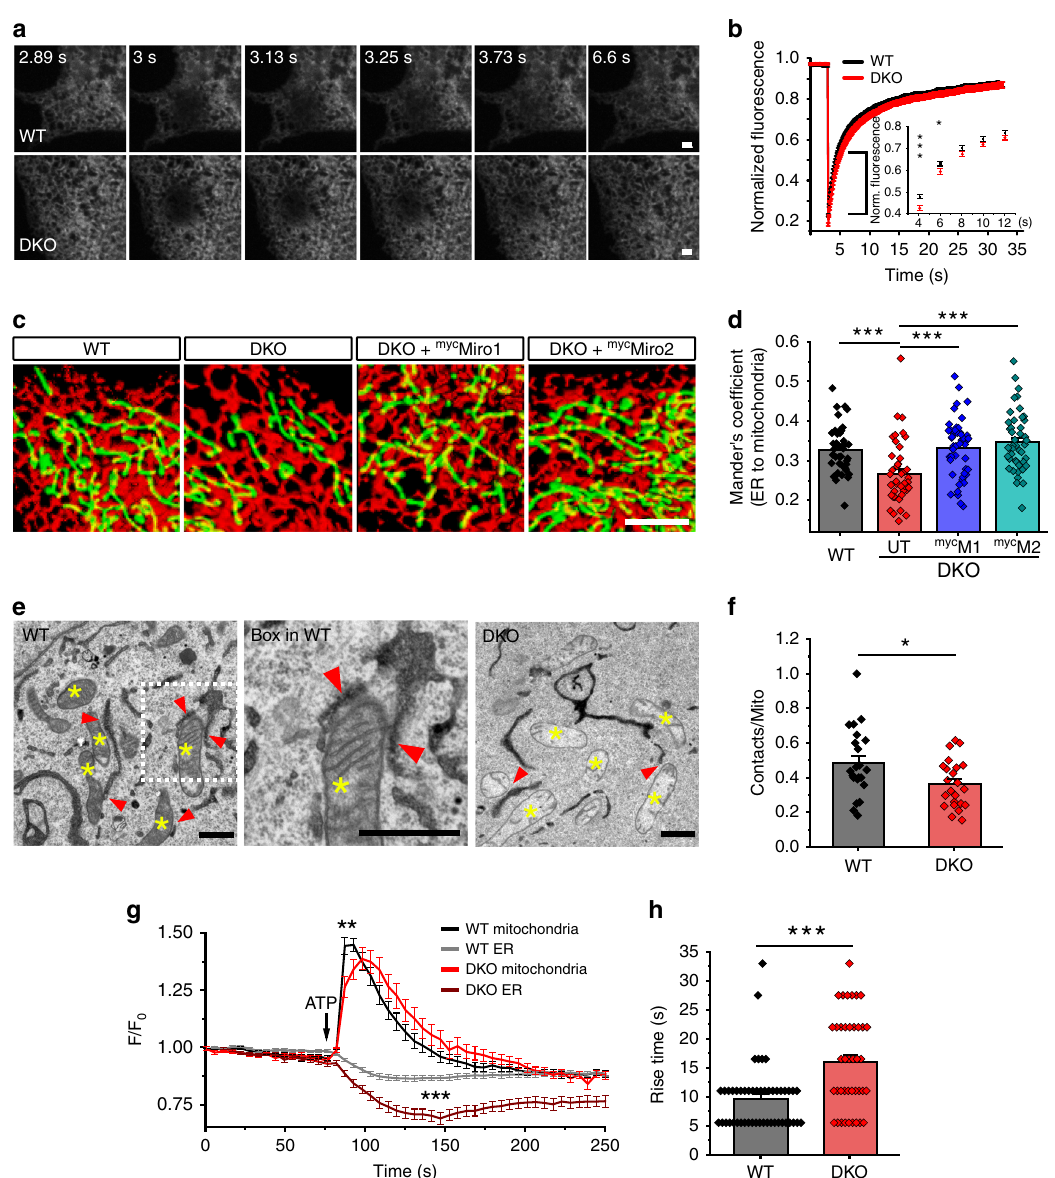
Fig. 2 Miro control ER/mitochondria communication by regulating the number of ERMCS. a FRAP analysis of ER dynamics measured in MEF cells transfected with DsRed ER (scale bar: 2 μ m). b Quanti fi cation of images shown in ( a ). Inset: expanded region of fi rst 12 s of the recovery after bleaching (fraction of recovery at 4 s: WT ~0.47 ± 0.01, DKO ~0.42 ± 0.01, p = 0.0010; and after 6 s: WT ~0.63 ± 0.01, DKO ~0.59 ± 0.01, p = 0.0311; Student ’ s t test with Welch ’ s correction; n = cells; in which 37 WT and 38 DKO cells were analyzed from three independent experiments). c Representative images of MEF cells expressing GFP Su9 and DsRed ER (scale bar: 10 μ m). d Quanti fi cation of Mander ’ s coef fi cient between the ER and mitochondria from ( c ) ( n = cells; in which 40 WT, 45 DKO, 47 DKO re-expressing Miro1, and 46 re-expressing Miro2 cells were used from three independent experiments; one-way ANOVA, Bonferroni post hoc). e Electron micrographs of the mitochondria and ER in WT and DKO cells expressing an HRP construct fused to an ER retention signal (KDEL). Yellow asterisks depict the mitochondria; red arrows point to the ER/mitochondria close contacts (< 35 nm). A magni fi ed view from the WT image depicts close contacts between the ER and mitochondria (scale bar: 200 nm). f Quanti fi cation of ERMCS in TEM images ( n = cell; in which 22 WT and 23 DKO cells were used, from two independent sample preparations; Student ’ s t test with Welch ’ s correction). g Agonist induced Ca 2 + release from the ER and subsequent mitochondrial Ca 2 + uptake. Arrow indicates addition of agonist ATP ( n = 49 WT and 41 DKO cells for the mitochondria and n = 47 WT and 39 DKO cells for ER were analyzed from fi ve independent experiments; Student ’ s t test with Welch ’ s correction). h Rise time (calculated from baseline to maximum amplitude after addition of ATP) in WT and DKO cells ( n = cells; in which 49 WT and 41 DKO cells from fi ve independent experiments were analyzed; Mann – Whitney ’ s U test). Error bars represent ± SEM. Signi fi cance: * p < 0.05; ** p < 0.01; and *** p < respectively 8,22,29 . To study whether Miro accomplishes a role in recovery between WT and DKO cells (Fig. 2a, b; mobile fraction regulating the connectivity of the ER membranes, we performed a WT M ~87 ± 7.5% against DKO M ~86 ± 8.2%, Mean ± SD; Student ’ s fl uorescent recovery after photobleaching (FRAP) assay in our t test), with just a delay in the initial recovery time (Fig. 2a, b; t 1/2 recovery time: 1.80 s ± 1.56 – 2.4 s for WT and 2.40 s ± 1.80 – 3.46 s MEF cell lines. FRAP analysis of ER-luminal-targeted DsRed for DKO; median ± interquartile range (IQR), Mann – Whitney ( DsRed ER) showed no signi fi cant difference in fl uorescence